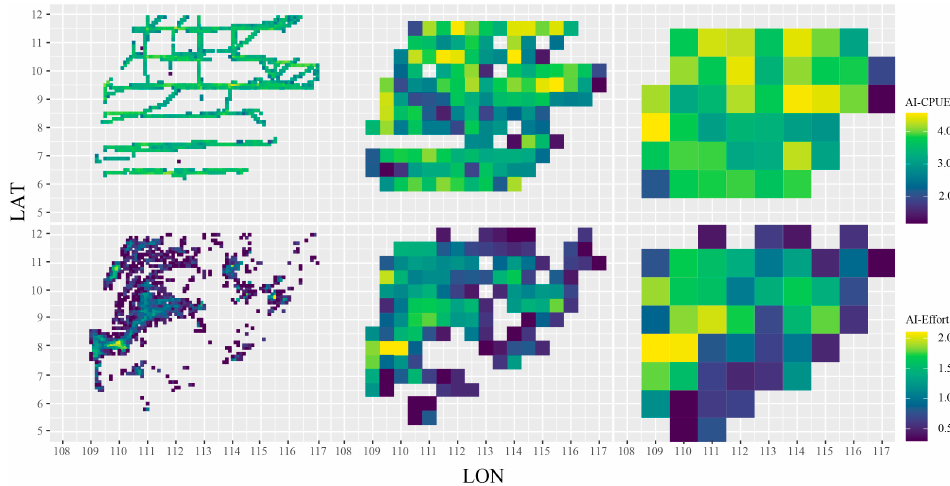
Figure 2. Distribution of AI-CPUE and AI-Effort at different spatial scales.